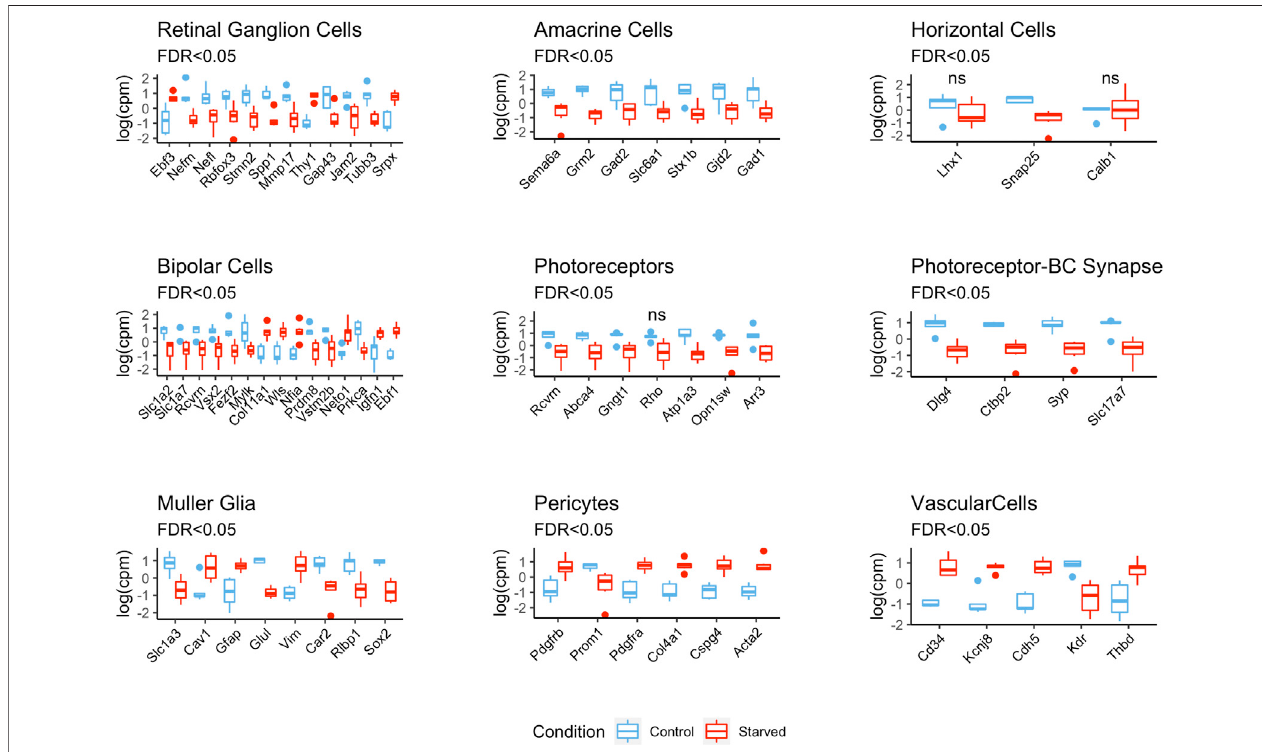
FIGURE2| Differentialexpressionofretinalcellmarkersbetweenstarvedandcontrolconditions.Theexpressionvaluesarecenteredandscaled( Supplementary Figure S4 shows unscaled plots with expression levels).